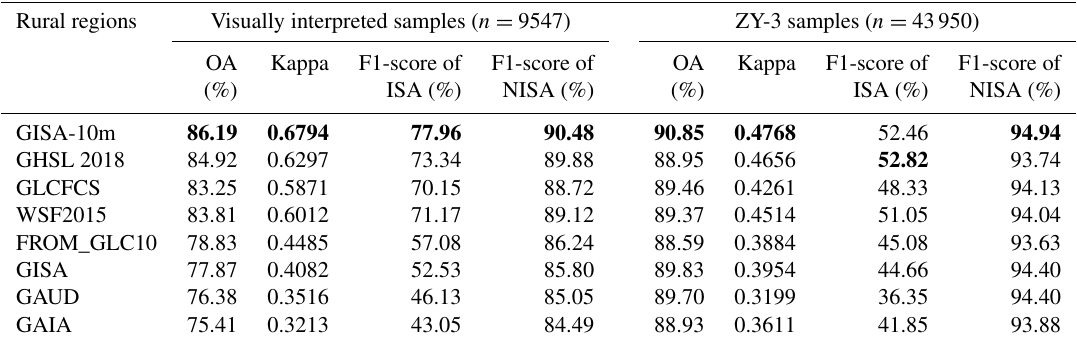
Table 4. Results of quantitative accuracy assessment via visually interpreted and ZY-3 samples in rural regions between GISA-10m and the existing ISA datasets. OA represents the overall accuracy. Bold numbers represent the highest value for each metric. Rural